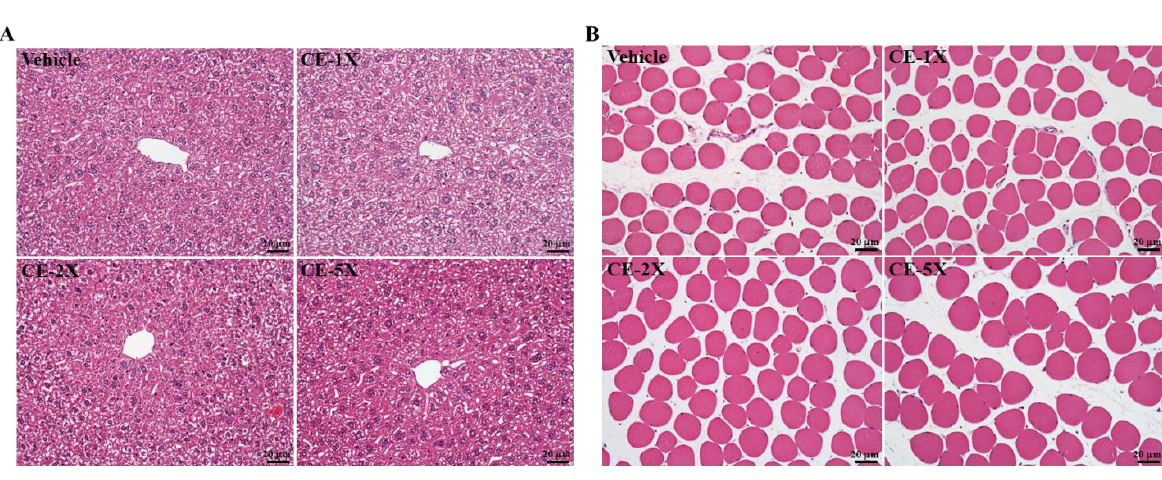
Figure 7. Effect of CE supplementation on histomorphologic features of the liver ( A ) and soleus muscle ( B ) in mice. Specimens were photographed under a light